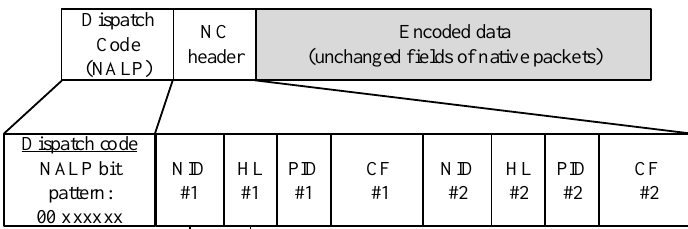
Figure 5. NC header format (for two encoded packets).